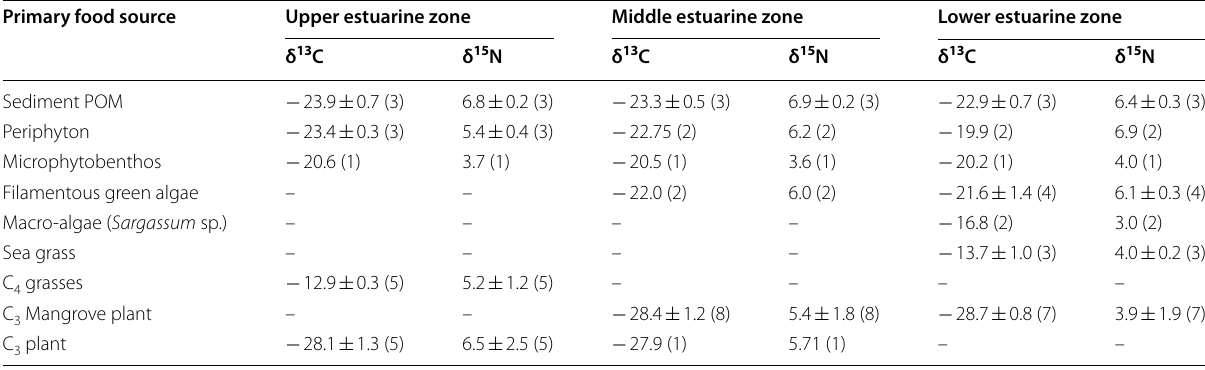
Sample size n for each autotrophic group is indicated in brackets. When n < 3 standard deviation values are not given =